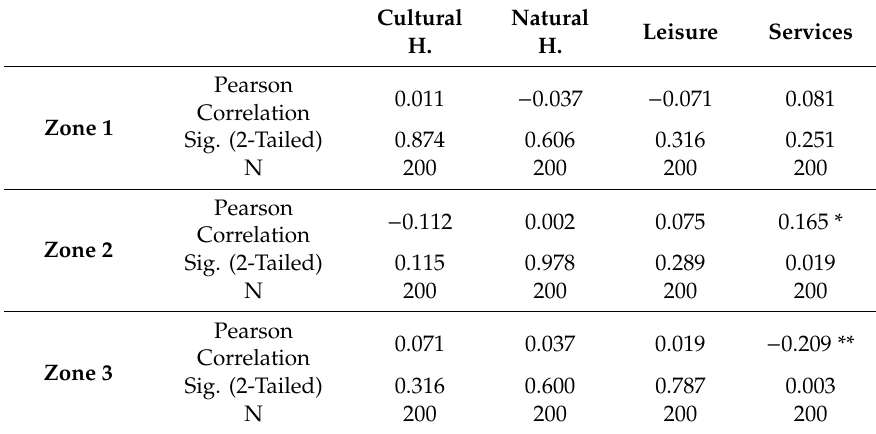
Table 6. Results of total amount of zone heritage crosstabs. Cultural H.